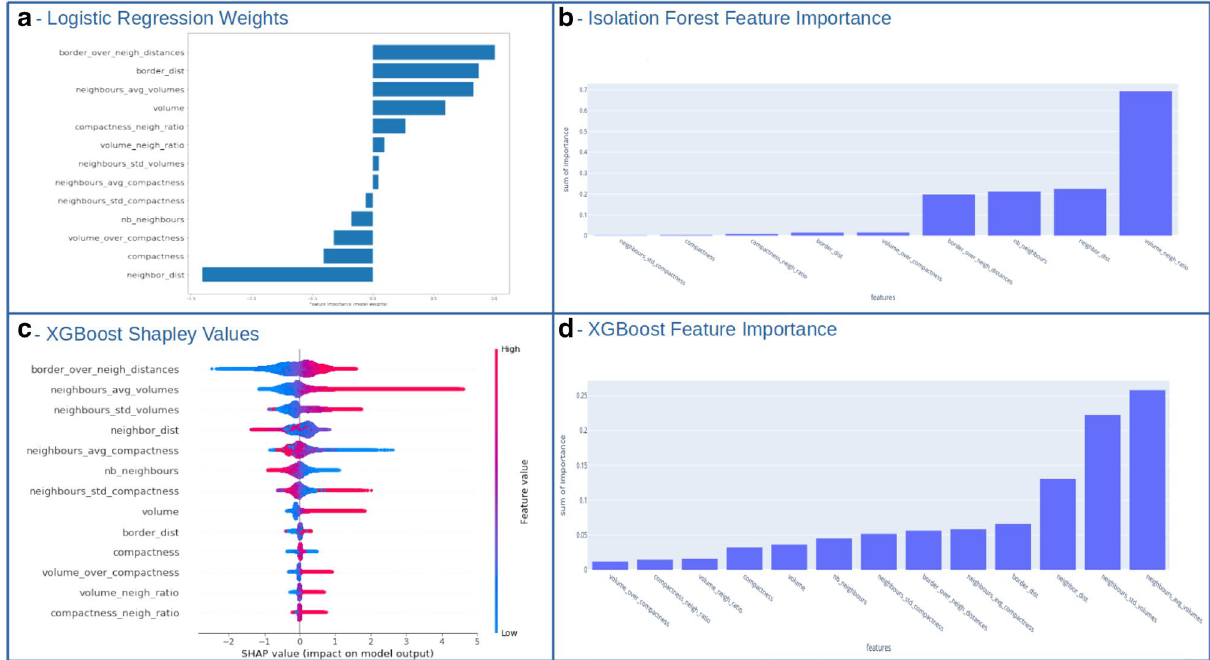
Figure 5. Models atypia definition interpretability: ( a ) Logistic regression model weights ( b ) Isolation Forest global feature importance ( c ) XGBoost Shapley values ( d ) XGBoost global feature